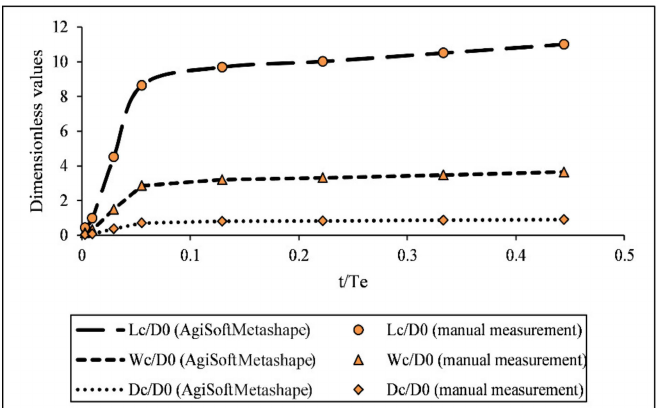
Figure 9. The accuracy of the temporal development of the sediment flushing cone with AgiSoft Metashape in comparison with the manually measured data using the best DBE structure in the no obstruction situation in various indices of flow dimensionless (note: t / T e is the dimensionless index of time elapsed since the beginning of the experiment, where t is the time elapsed since the beginning of the experiment (min) and T e is the time duration of scour equilibrium